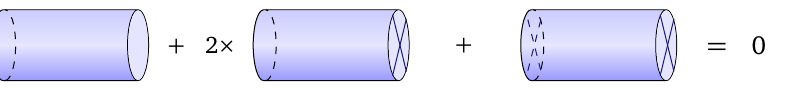
Figure 4: The tadpole cancellation condition. The Möbius strip is represented by a cylinder with one crosscap (the “X” at the end) and we must include separate contri- butions from crosscaps on the left and right ends. The Klein bottle is represented by a cylinder with two